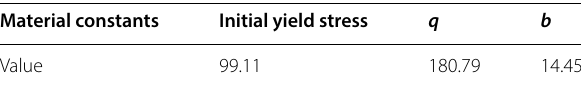
Table 2 Material constants for the Voce-shaped stress- strain relationship